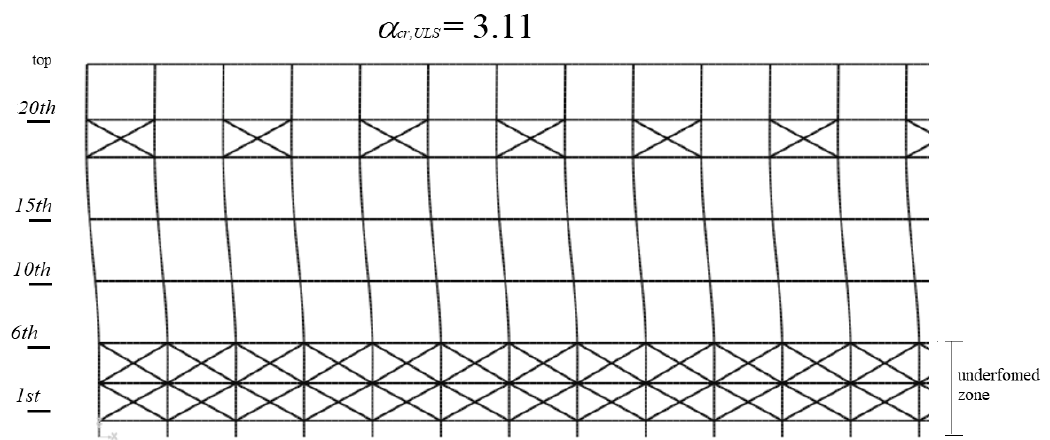
Figure 8. Buckling deformed shape for ultimate limit state (ULS) (on the left indication of the storage levels).